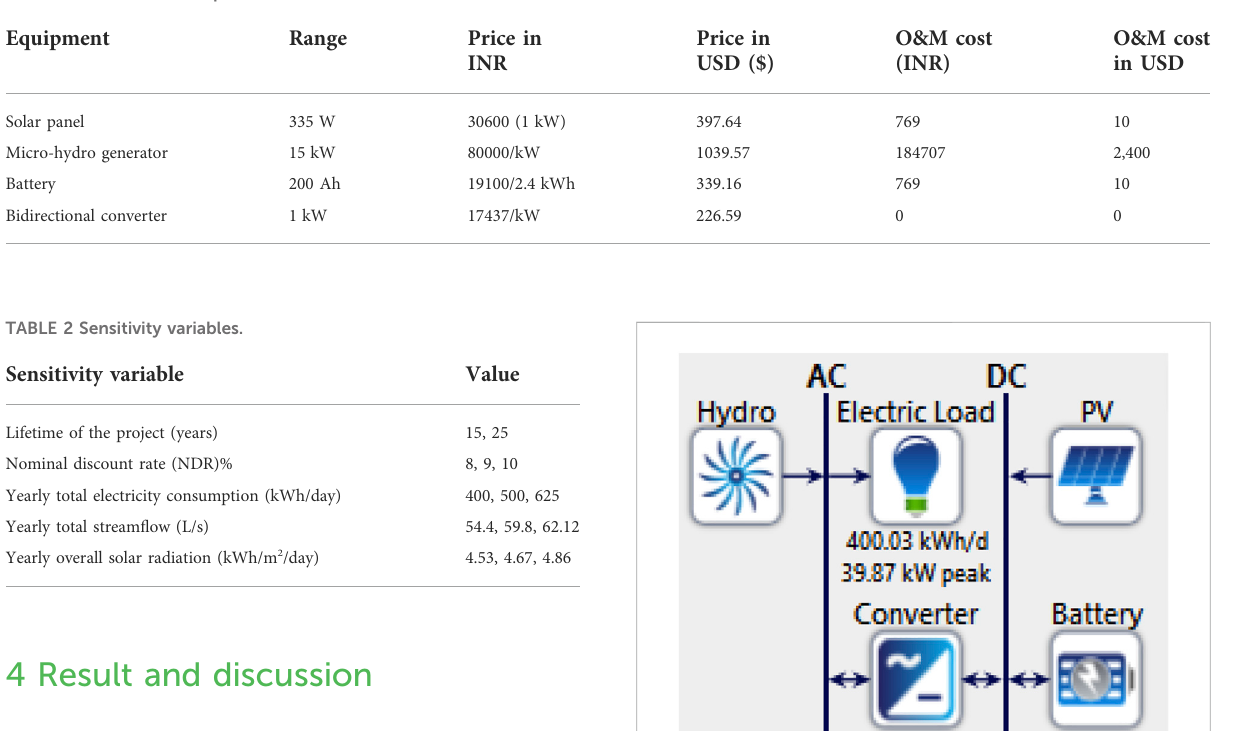
TABLE 1 Cost of the components (Ali et al., 2021), (Reserve bank, 2022).